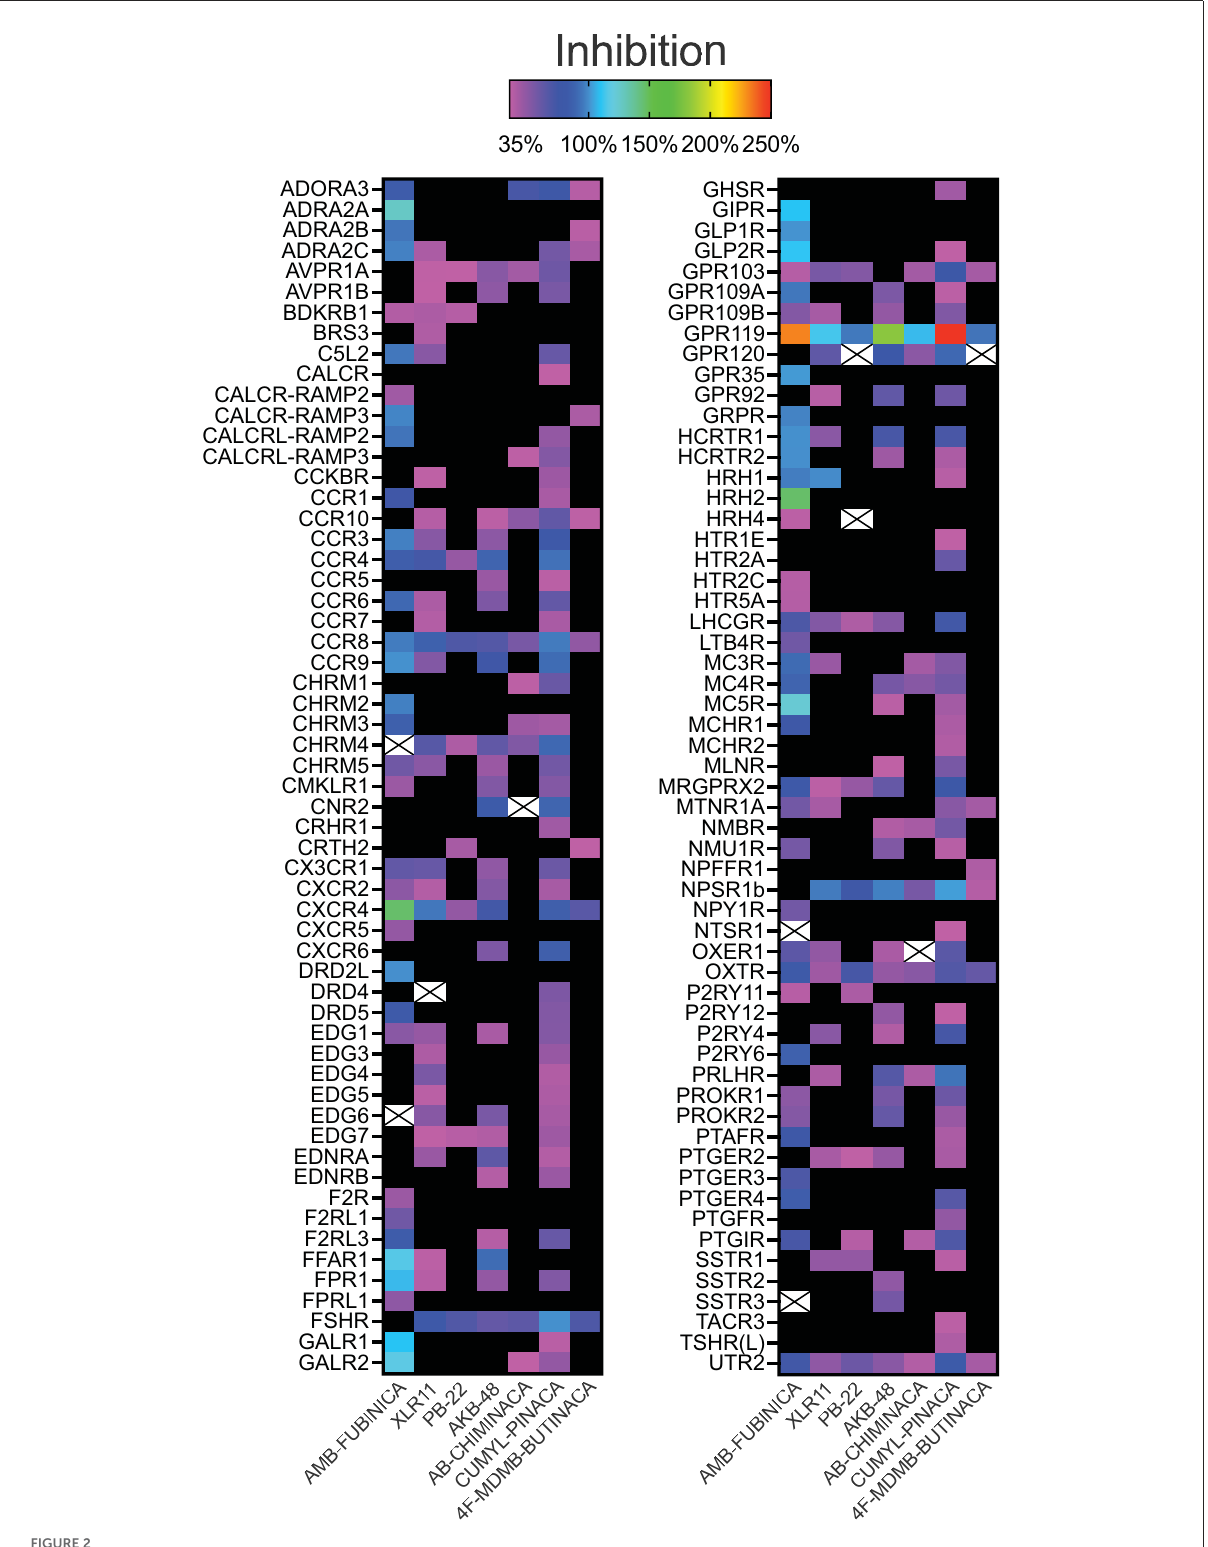
FIGURE2 Inhibitory activity of the SCRAs AMB-FUBINACA, XLR11, PB-22, AKB-48, AB-CHMINICA, CUMYL-PINACA, and 4F-MDMB-BUTINACA at 30 µ M in a β -arrestin recruitment screen. Heatmap depicting targets where above-threshold inhibition ( > 35%) was reached with at least one SCRA. Crosses indicate where antagonism was > 35% but had S/N < 1 or CoV > 1. The full list of targets screened is included as Supplementary Table